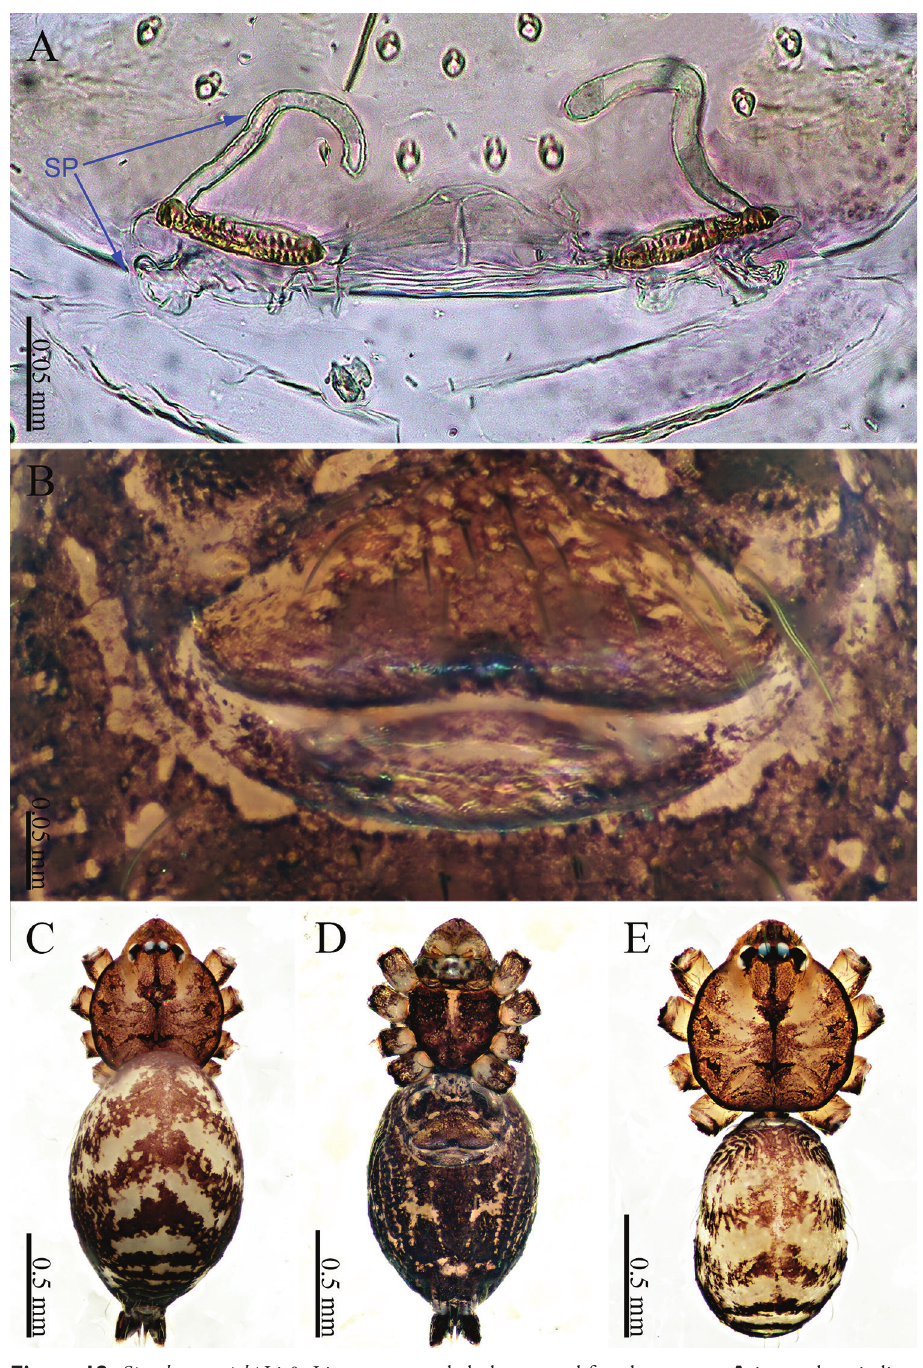
Figure 12. Sinoderces taichi Li & Li, sp. nov., male holotype and female paratype A internal genitalia, dorsal view B female epigastric furrow, ventral view C female habitus, dorsal view D female habitus, ventral view E male habitus, dorsal view. Abbreviation: SP